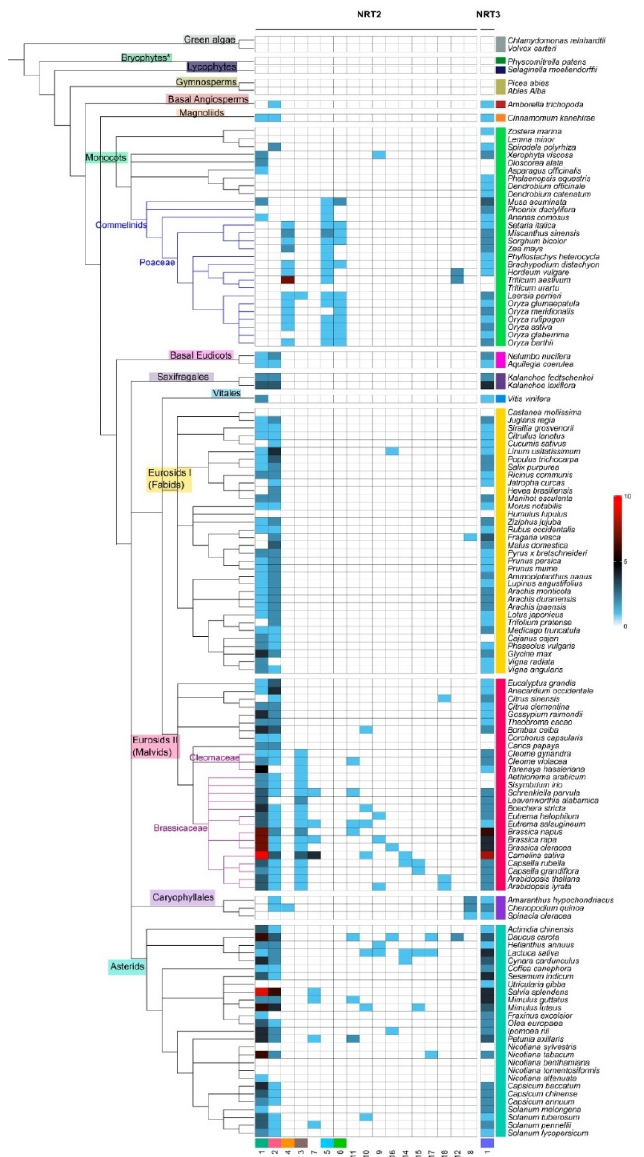
Figure 3. Heat map with the distribution of the syntenic communities of NRT2 genes in the species. Phylogenetic representation of the plant species and the distribution of the gene number belonging to each community (columns identified with number at the bottom) for each species (rows) in the different taxonomic groups (identified with different colors). The blue cells represent the presence of genes into syntenic communities (quantity per color scale) in the different species.